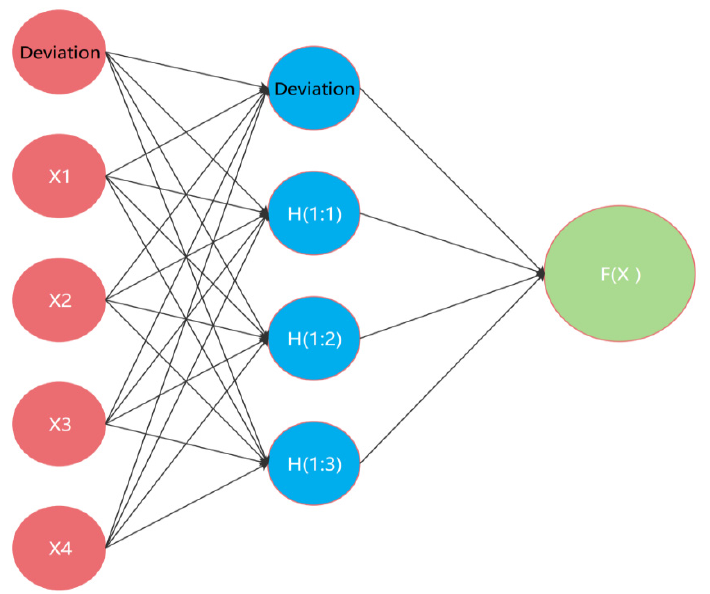
Figure 2. Network structure of multilayer perceptron.